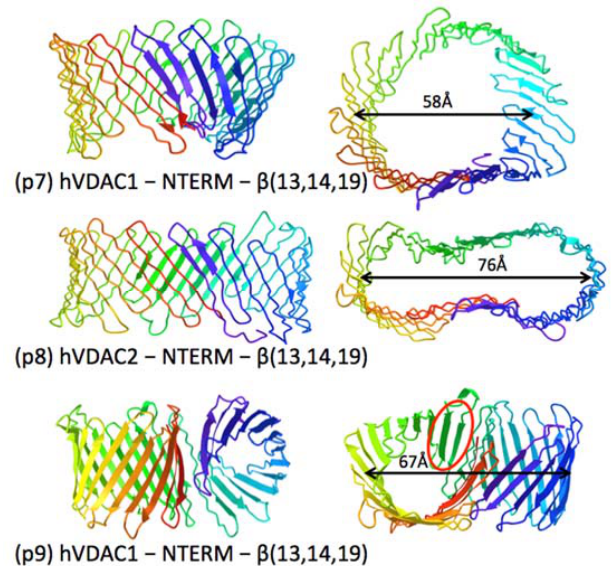
Figure 4. Folding predictions for hVDAC tandem repeat